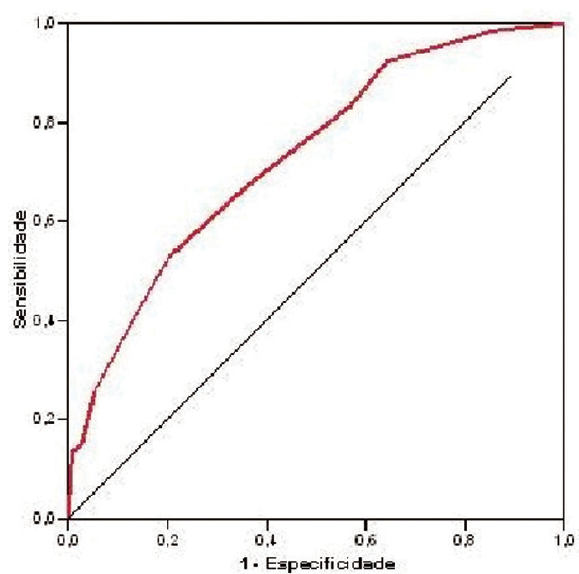
Fig. 1 – Gráfico da Curva ROC. Resultado da análise univariada